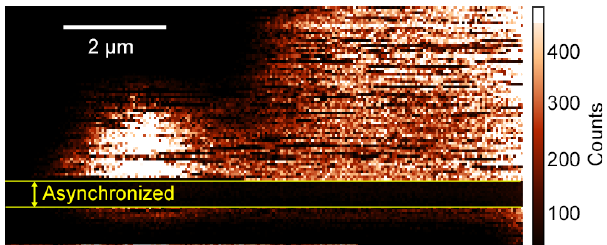
Fig. 4. CARS image with synchronized pulses and asynchro- nized pulses (yellow